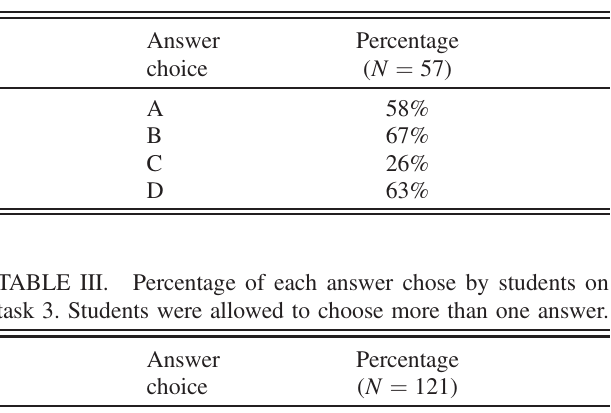
TABLE II. Percentage of each answer chose by students on task 2. Students were allowed to choose more than one answer.